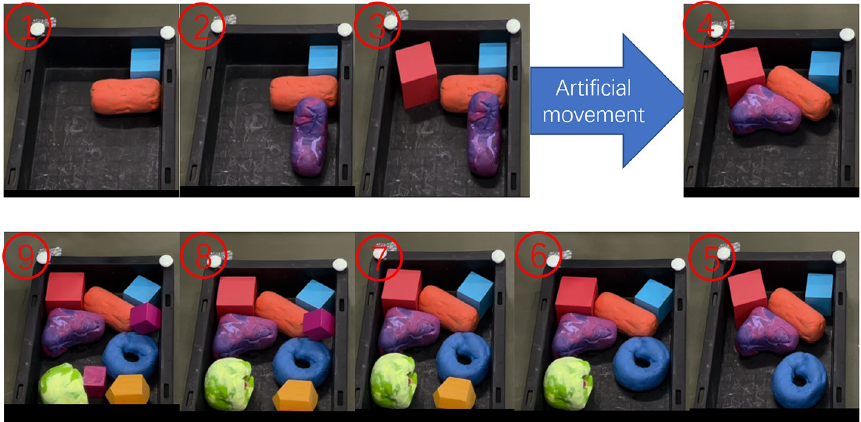
Fig 16. The whole process of the physical experiment. The agent obtains the layout information of the bin through the hand-eye camera. During the assembly process, the original layout of the bin is artificially disturbed, and the agent still works